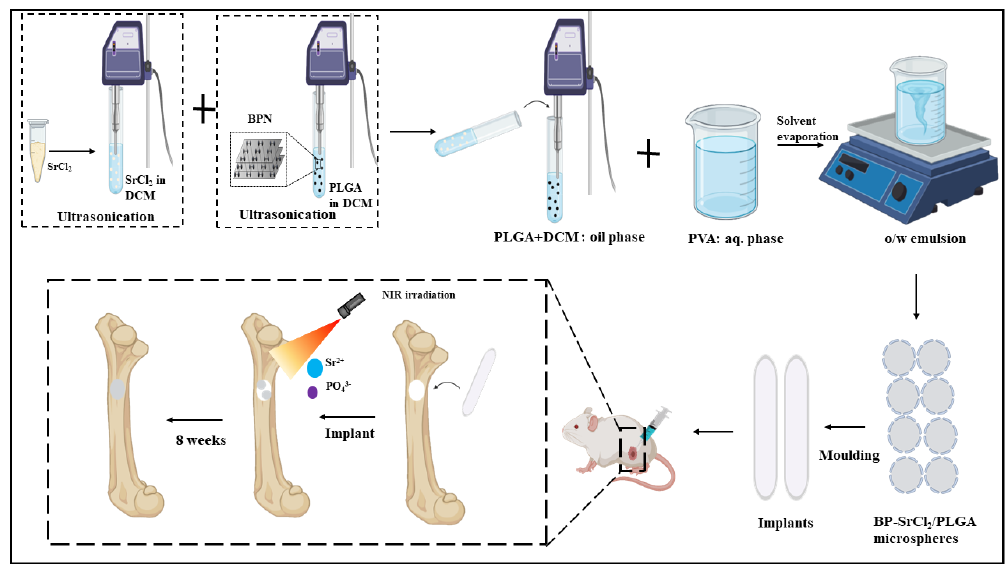
Figure 6. Schematic representation of BP-SrCl 2 /poly D,L-lactic-co-glycolic acid (PLGA) synthesis and its therapeutic application in bone regeneration.